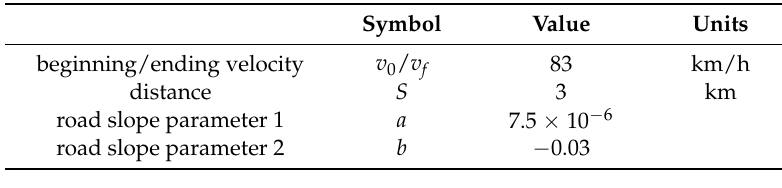
Table 3. Parameters for the concave road profile situation.